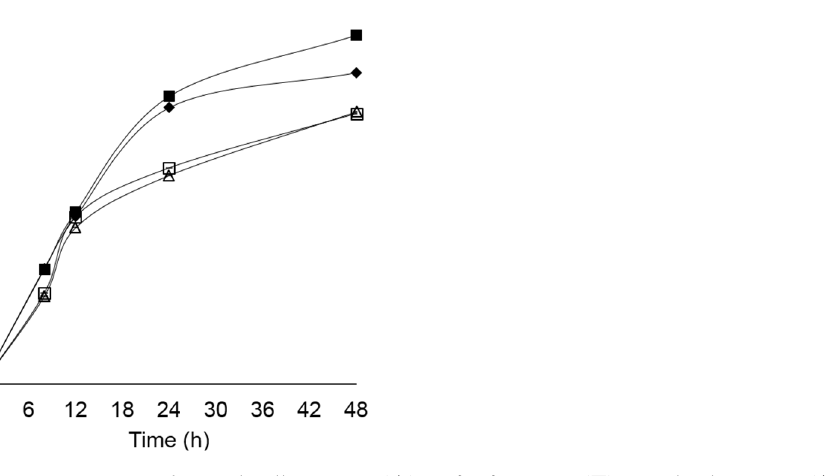
Figure 2. Growth of bacterial isolates in NB ( a ), NB supplemented with 2% urea ( b ), TSB ( c ), and TSB supplemented with 2% urea ( d ); Lysinibacillus sp. 2.2 ( △ ), L . fusiformis 3.7 ( □ ), L. xylanilyticus 4.3 ( ♦ ), L. fusiformis 5.1 ( ■ ). Values are mean ± SD. The SD value was shown in supplementary Table S1. (cid:1)